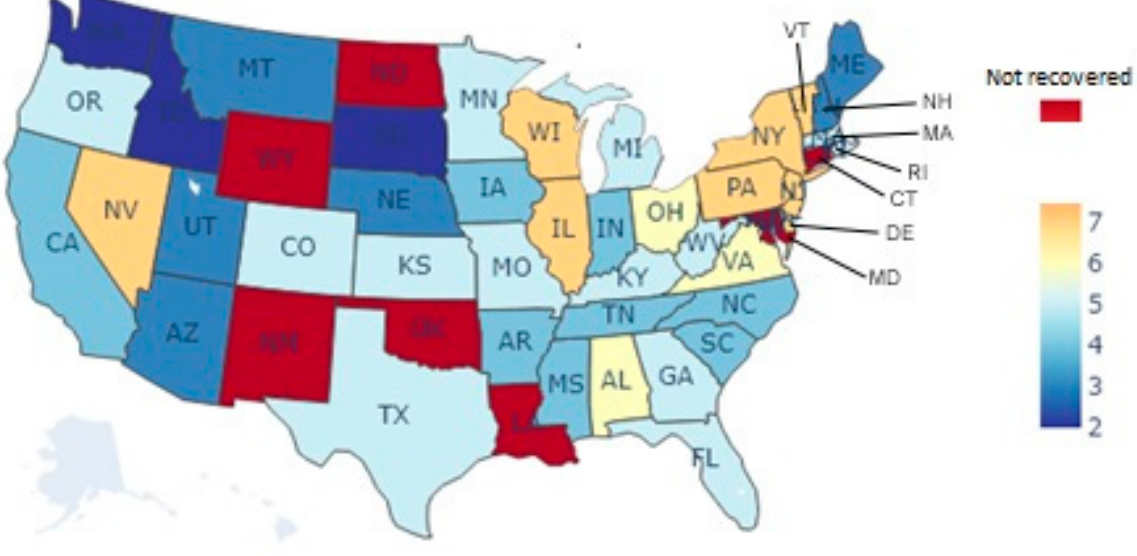
Figure 6. The number of quarters to recover to the GDP level in the 4th quarter of 2019.